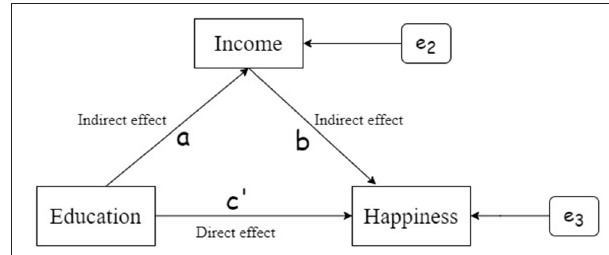
FIGURE 2 | Intermediate effect of education on